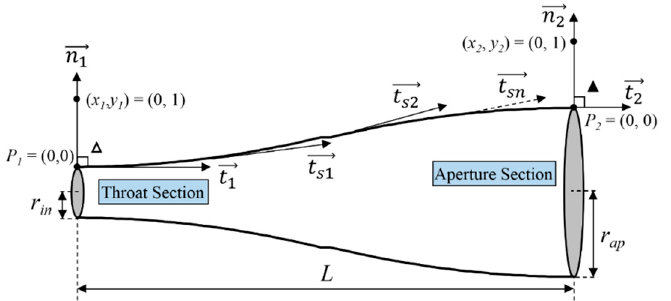
Figure 1. Geometry of the proposed profile smooth circular waveguide horn (with 2 node points) designed using biarc Hermite polynomial interpolation with principal unit normal vector points as ( x 1 , y 1 ) = ( x 2 , y 2 ) = (0, 1); r in = 0.8 mm; r ap = 8.50 mm; L = 50 mm for a center frequency of 140 GHz [16].